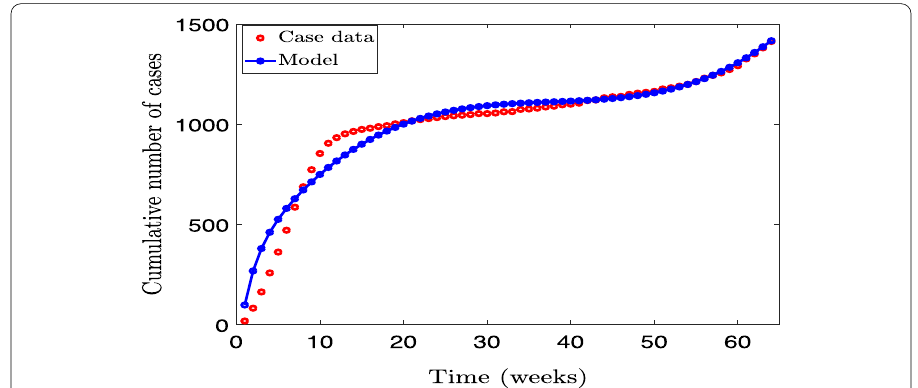
Fig. 4 Data fitting of the Lassa fever model (1) using cumulative confirmed cases data for Nigeria, from first week January 2020 to eleventh week in 2021. Reported cases are obtained from NCDC database